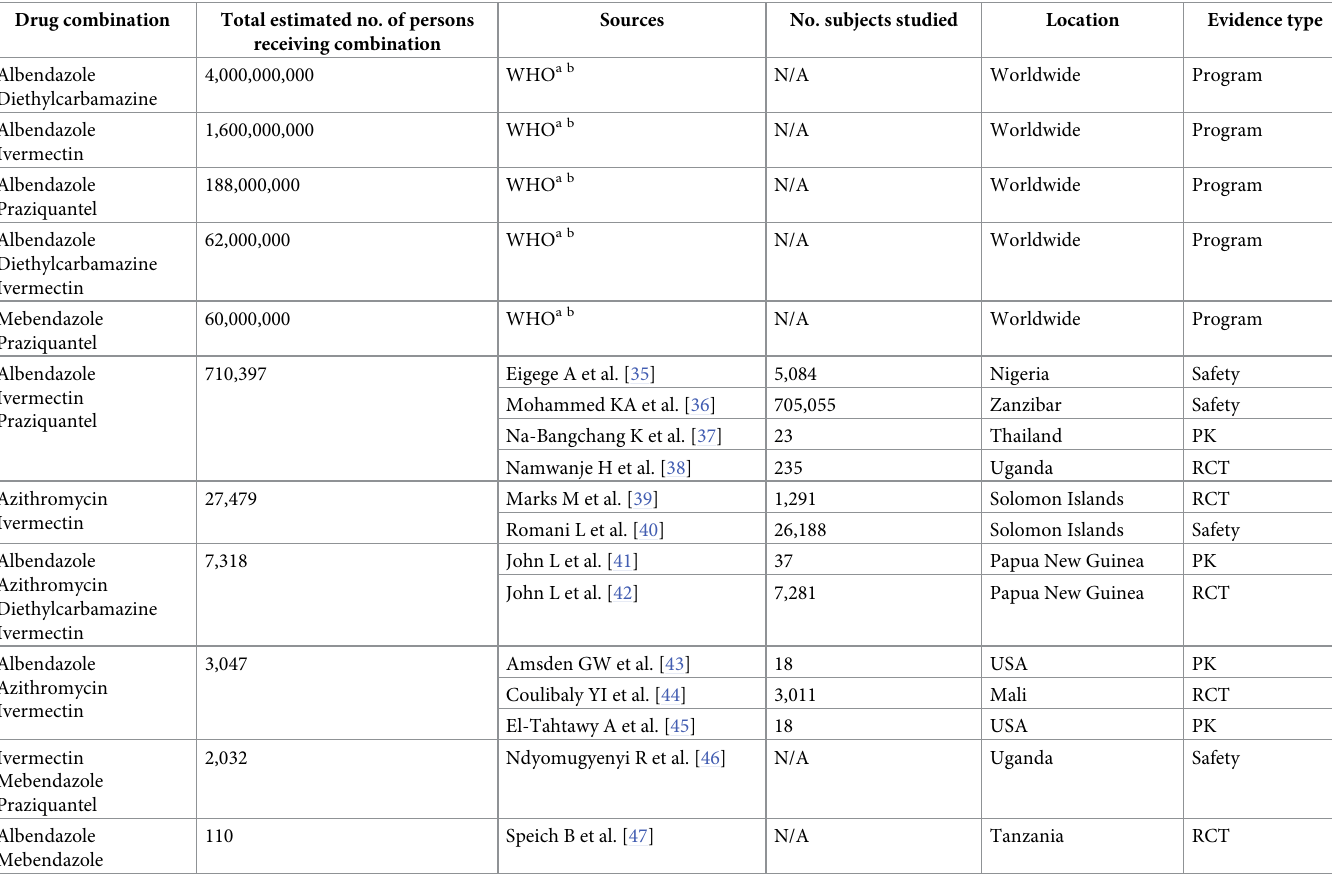
Table 3. Estimated number of persons receiving coadministered drugs used in preventive chemotherapy for NTDs, by drug combination, as well as source of these estimates. Drug combination Total estimated no. of persons receiving